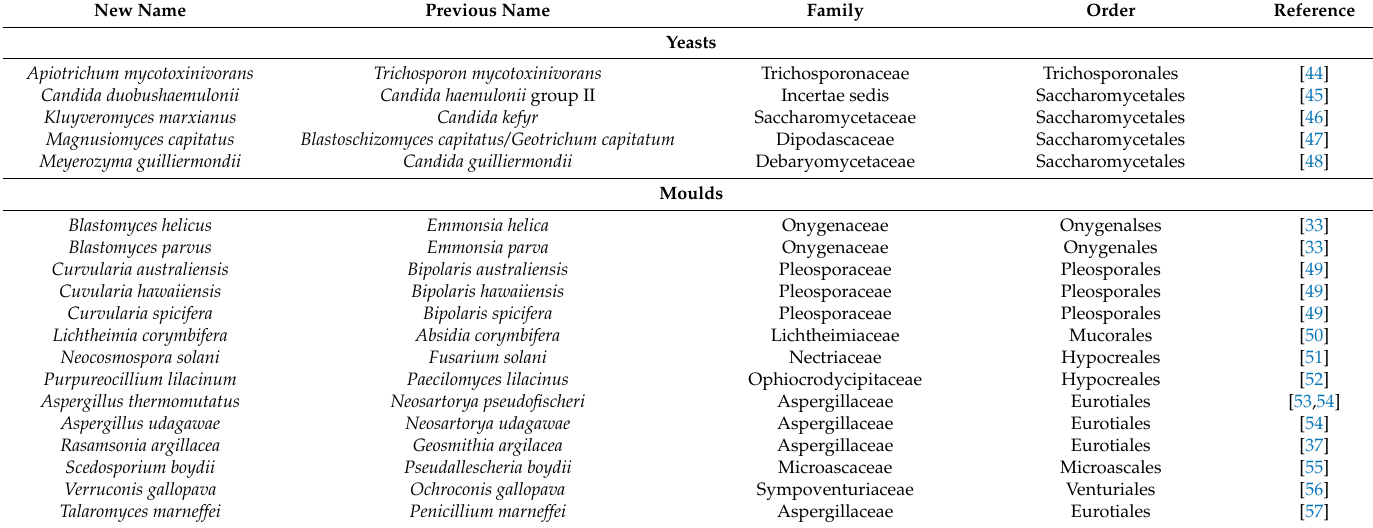
Table 2. Examples of fungal nomenclature changes in medically relevant